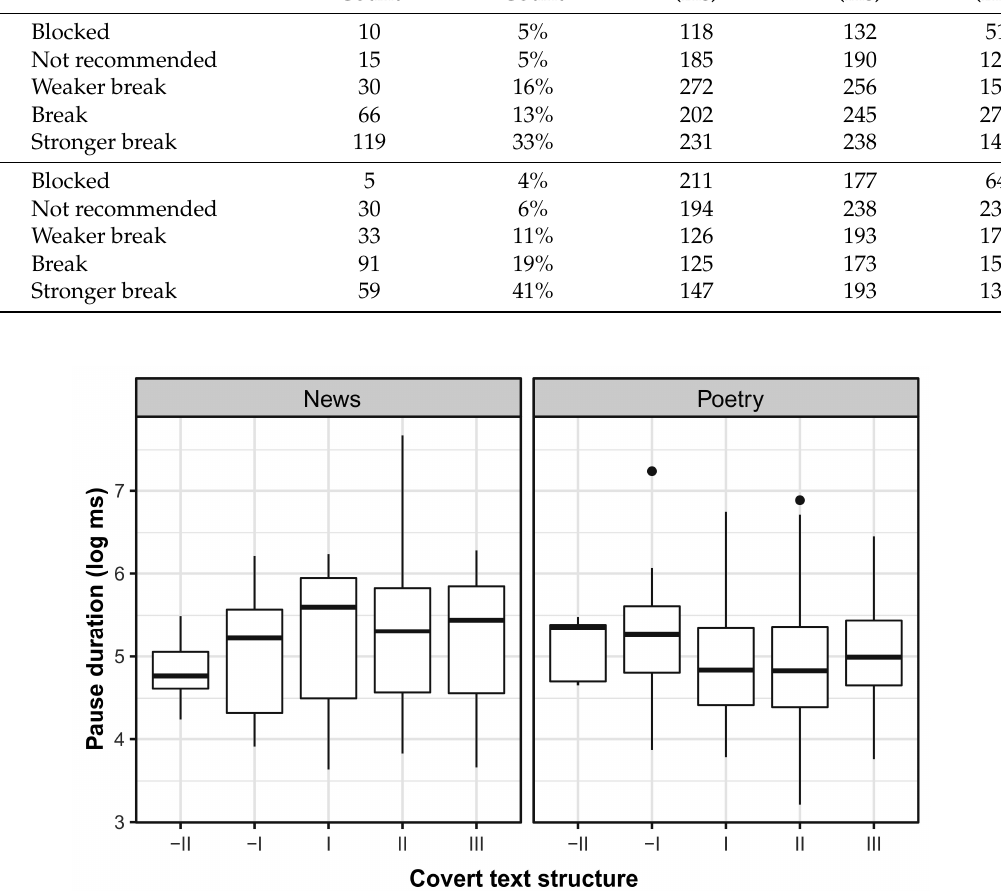
Table 2. The occurrence (absolute and relative) of pauses and their duration as a function of the grammatically informed analysis (Franz et al. 2022) in two genres. Only pauses in within-unit non-punctuated contexts are analyzed. The relative occurrence denotes the percentage of realized to potential pauses in the given pause category context. For an explanation of levels, see Section 2.3. Median dur. Mean dur. Absolute Count Relative Count (ms)